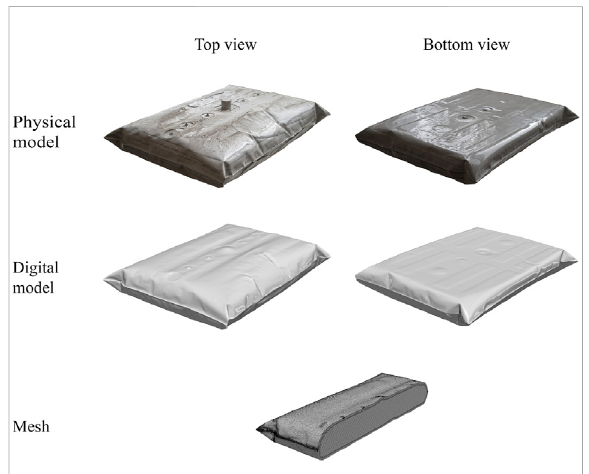
FIGURE 5 Analogous to the work fl ow shown in Figure 4, the mesh for the CELL-tainer was also created with expansion channels. Here, too, a physical model was fi rst created, which served as atemplate for the digital model. In this case, the air pockets on the top sideweremoreextremethaninthestandardmodel.However,this was easily fi xed in post-processing with Blender. A half section of the mesh is also shown here to visualize the wall